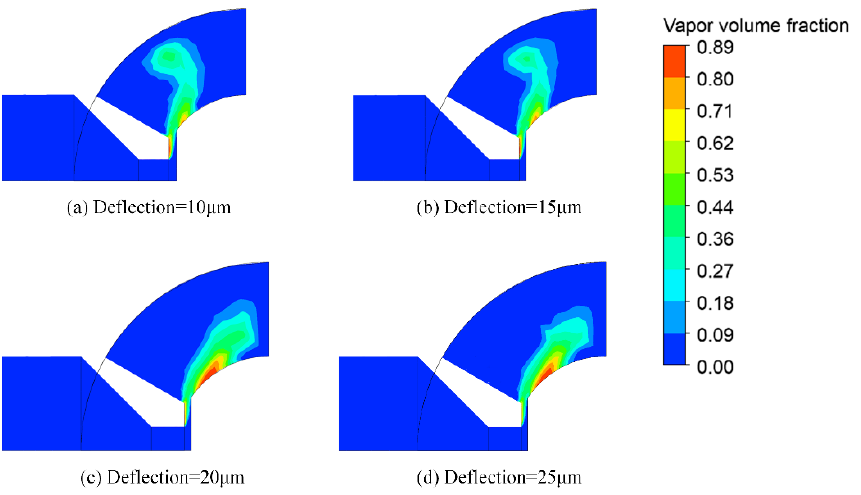
Figure 18. Cavitation phenomenon in the pilot stage with different deflection. ( a ) Cavitation phenomenon in the pilot stage with the deflection of 10 μ m; ( b ) Cavitation phenomenon in the pilot stage with the deflection of 15 μ m; ( c ) Cavitation phenomenon in the pilot stage with the deflection of 20 μ m; ( d ) Cavitation phenomenon in the pilot stage with the deflection of 25 μ m.